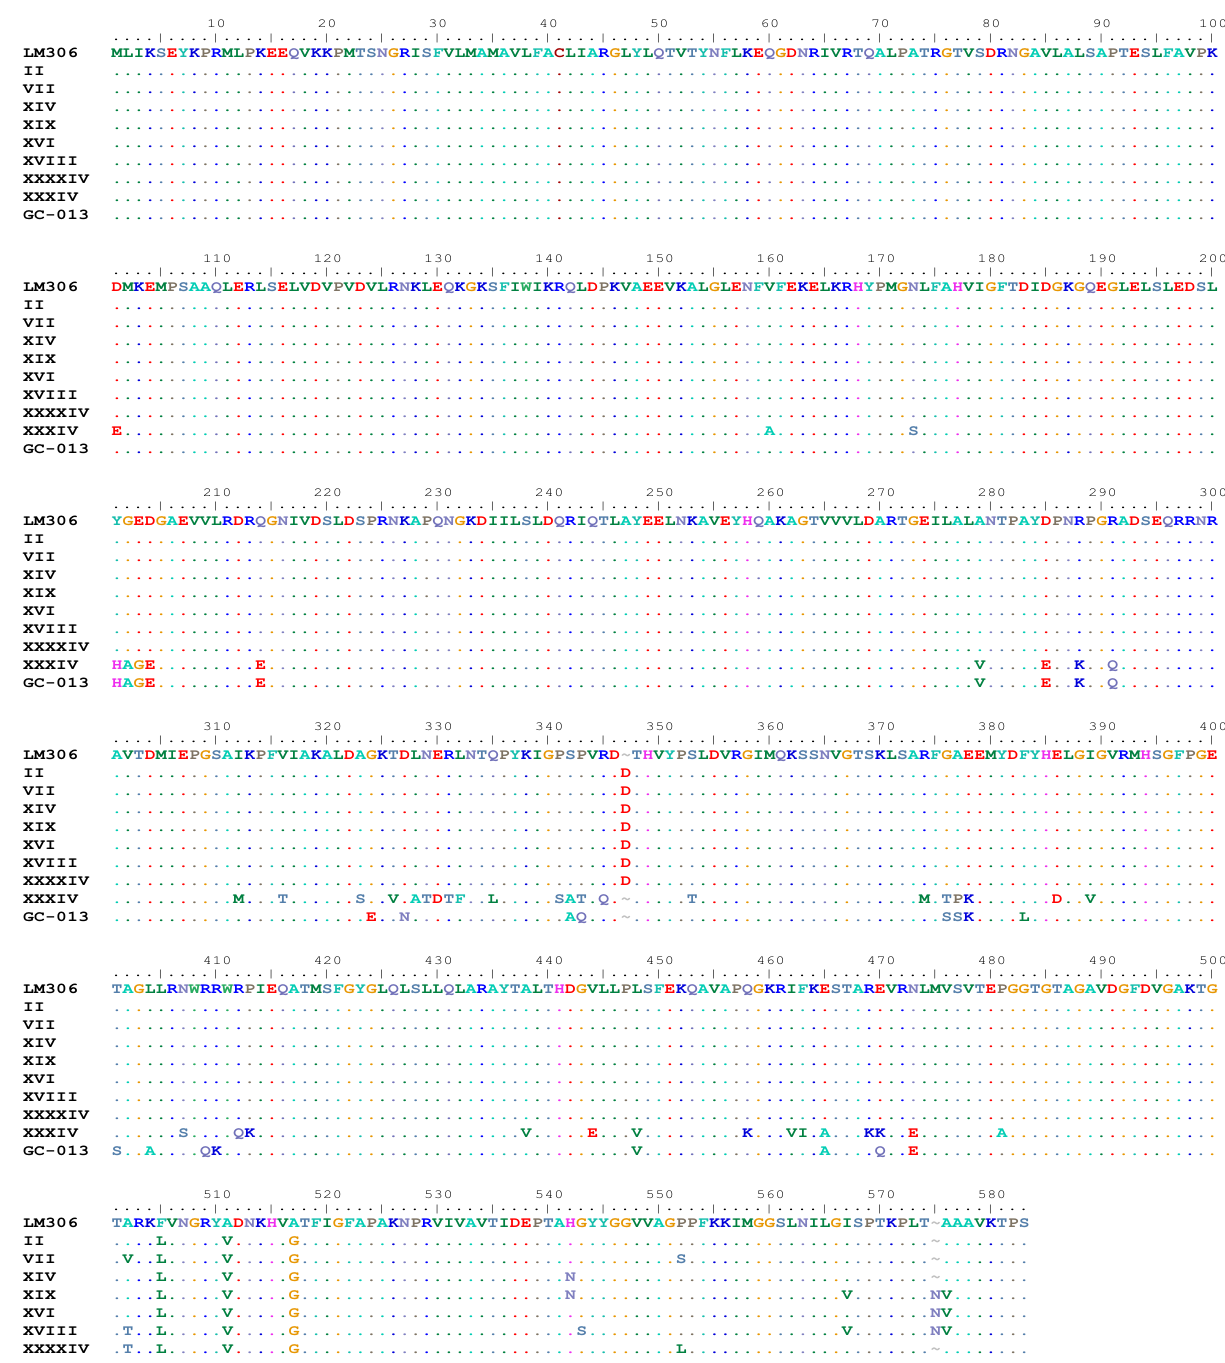
TAGLLRNWRRWRPIEQATMSFGYGLQLSLLQLARAYTALTHDGVLLPLSFEKQAVAPQGKRIFKESTAREVRNLMVSVTEPGGTGTAGAVDGFDVGAKTG II